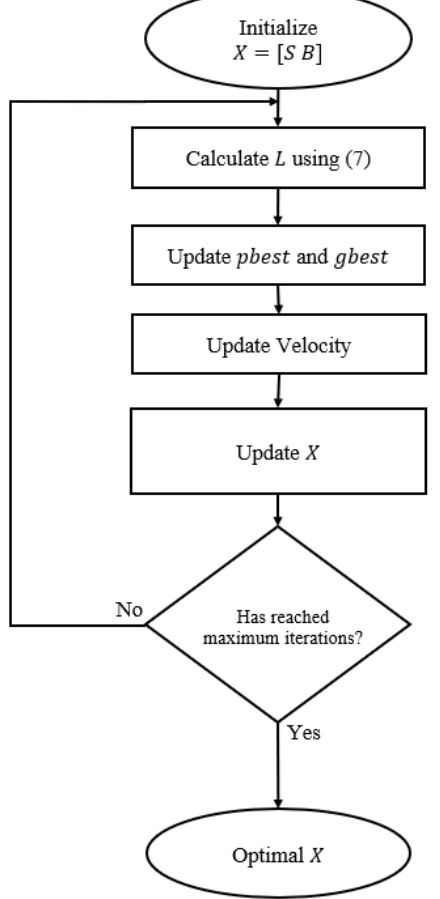
Figure 5. Flow chart of PSO in DARS, where position matrix X contains scales and biases. The theoretical background of PSO is provided in Section 3.2